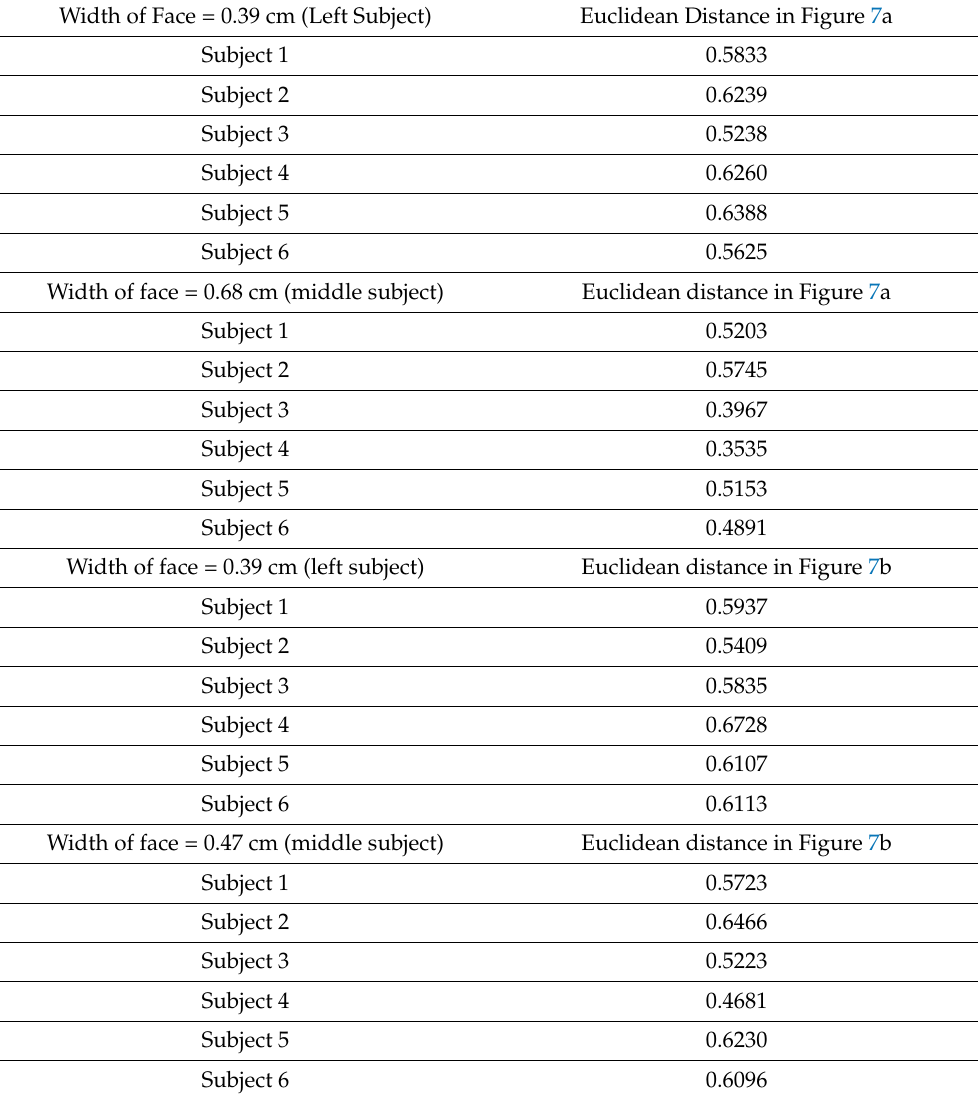
Table 2. The values of the Euclidean distance with respect to two subjects when the sizes of faces are different, as in Figure